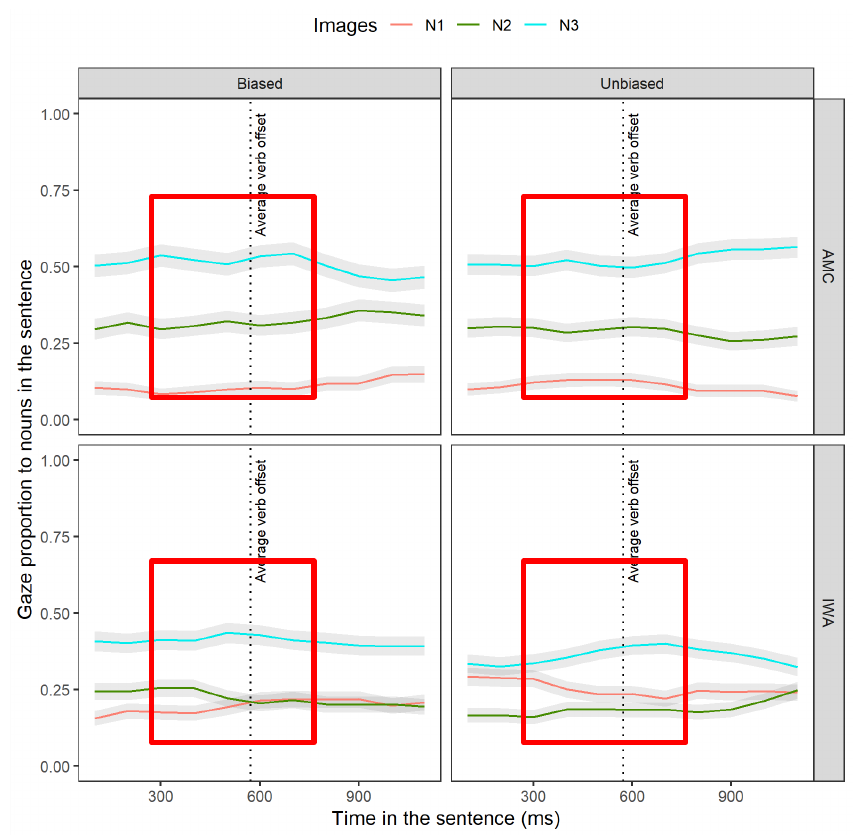
Figure 7. Averaged gaze proportions to N1, N2, and N3 between groups and conditions. This is the raw data observation of gaze toward N1, N2, and N3 in the verb-frame window. The gray shaded ribbons around the lines represent standard errors. The red boxes indicate the window in which the effect is expected.